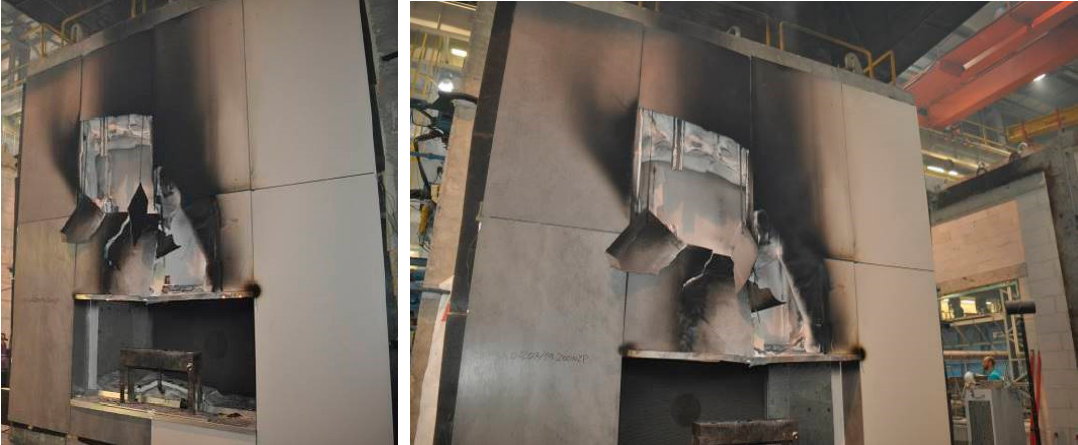
Figure 5. Ventilated facade model view after the fire source was extinguished and the test was Figure5. completed.